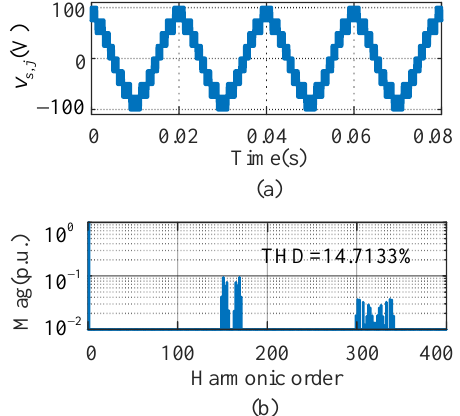
Figure 9. Theoretical output voltage of PSC1. ( a ) Waveform of equivalent output-phase voltage; ( b ) fast Fourier transform (FFT) analysis.